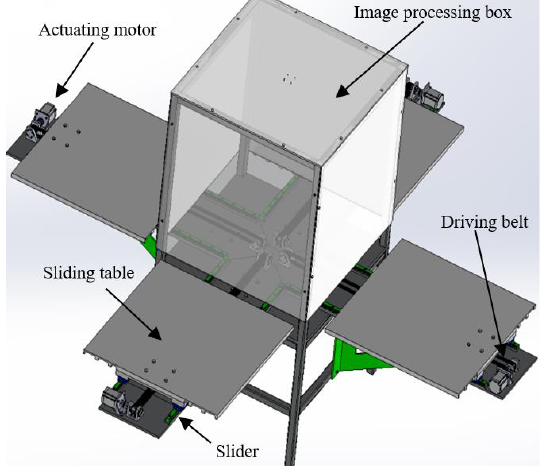
Figure 1. Proposed mechanical